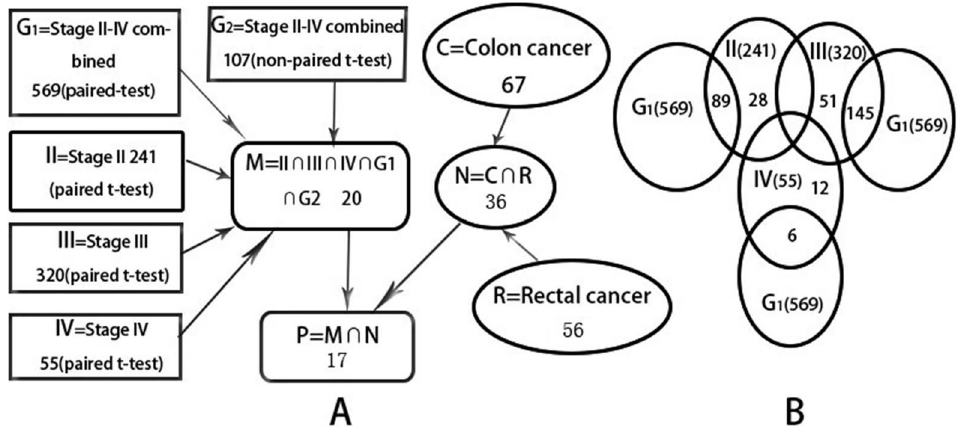
Figure 1. The intersection among results in our study. According to the TNM staging and origin of tissues, CRC patients were divided into stages II, III, or IV colon or rectal cancer. There were 17 dysregulated miRNAs with a similar expression pattern in all 7 groups (II, III, IV, G1, G2, C, and R); 28 dysregulated miRNAs were found only in stage II and 51 only in stage III, but stage IV had 12 dysregulated miRNAs.